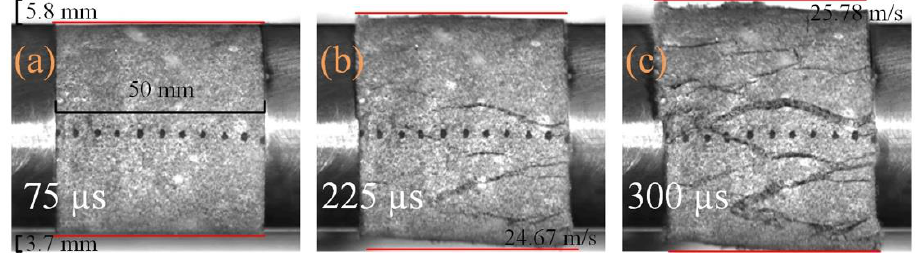
Figure 16. The high-speed images of fragments in a typical test: ( a ) 75 µs; ( b ) 225 µs; and ( c ) 300